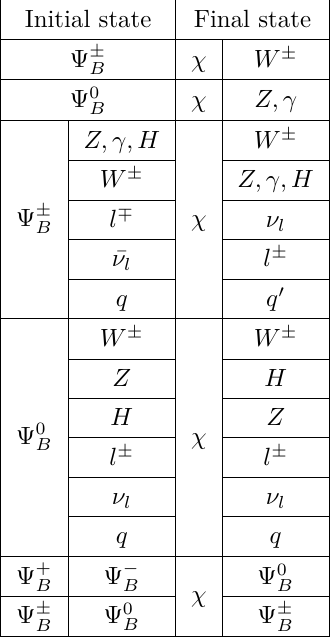
Table 5. Decay and scattering processes, Initial state → Final state, contributing to the freeze-in production of DM for the singlet-triplet